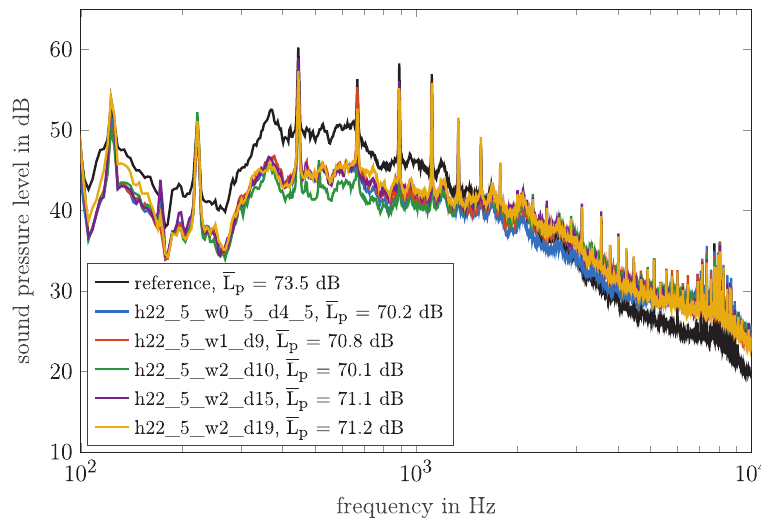
_ V ¼ 1.1 m 3 s (cid:1) 1 at a constant rotational